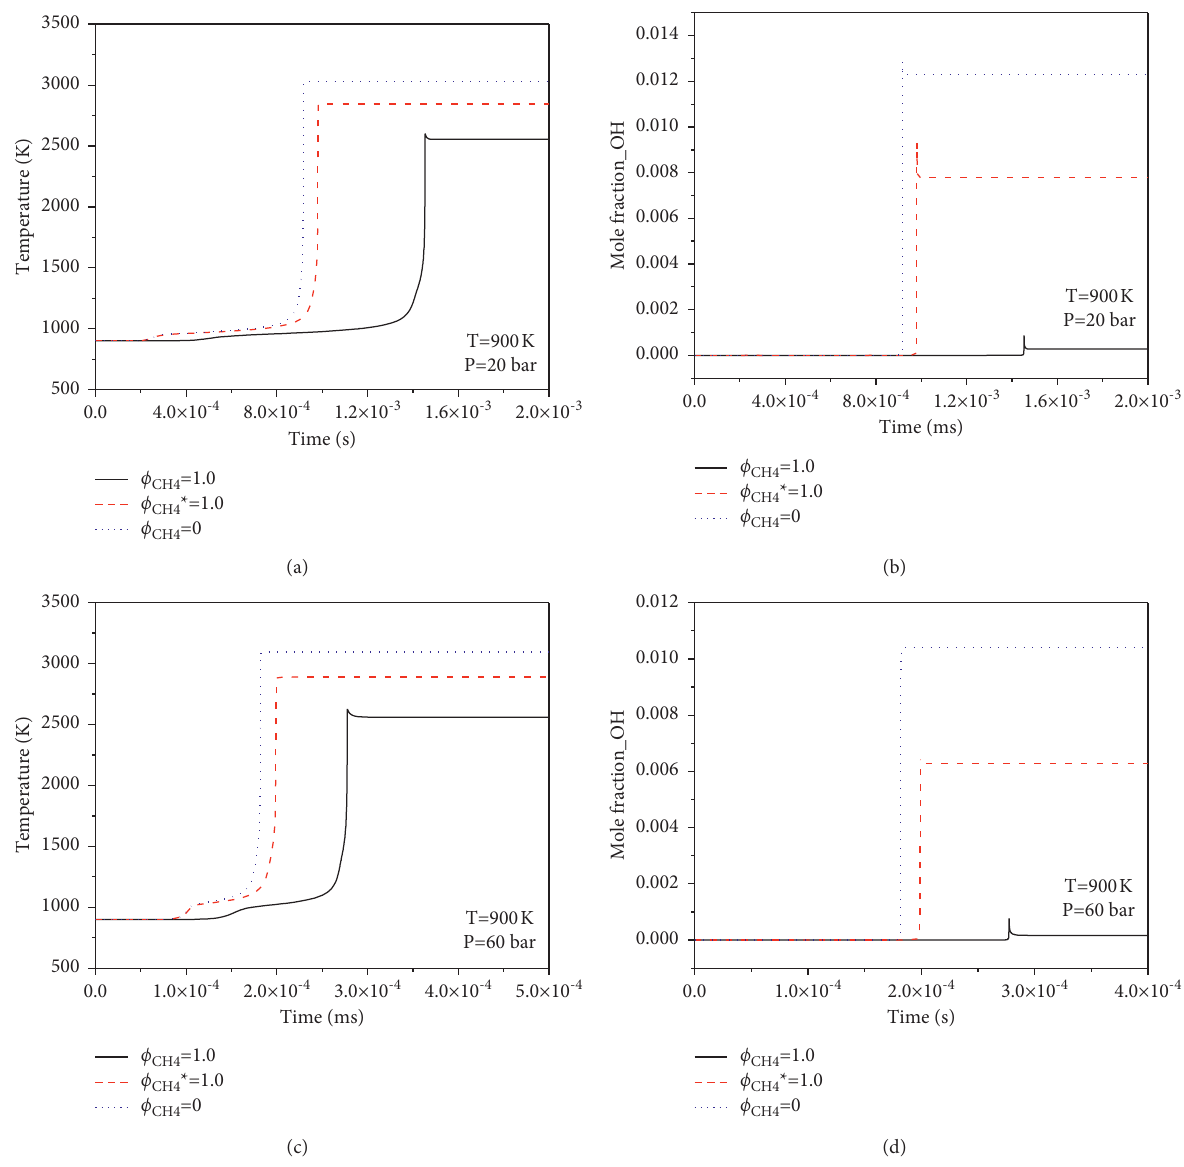
Figure 9: Effect of different methane equivalence ratios on the evolution of temperature and OH